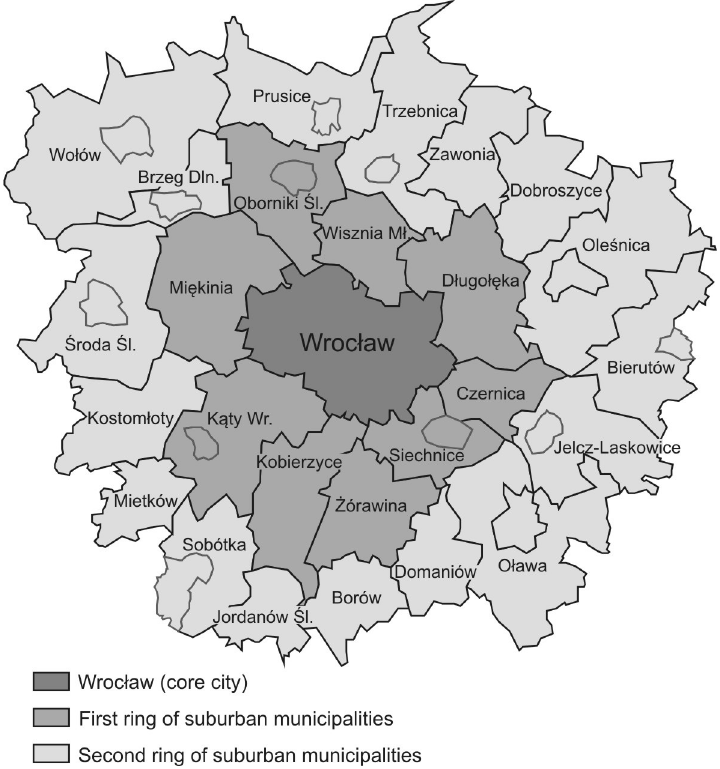
Fig. 1. Municipalities forming the Wrocław